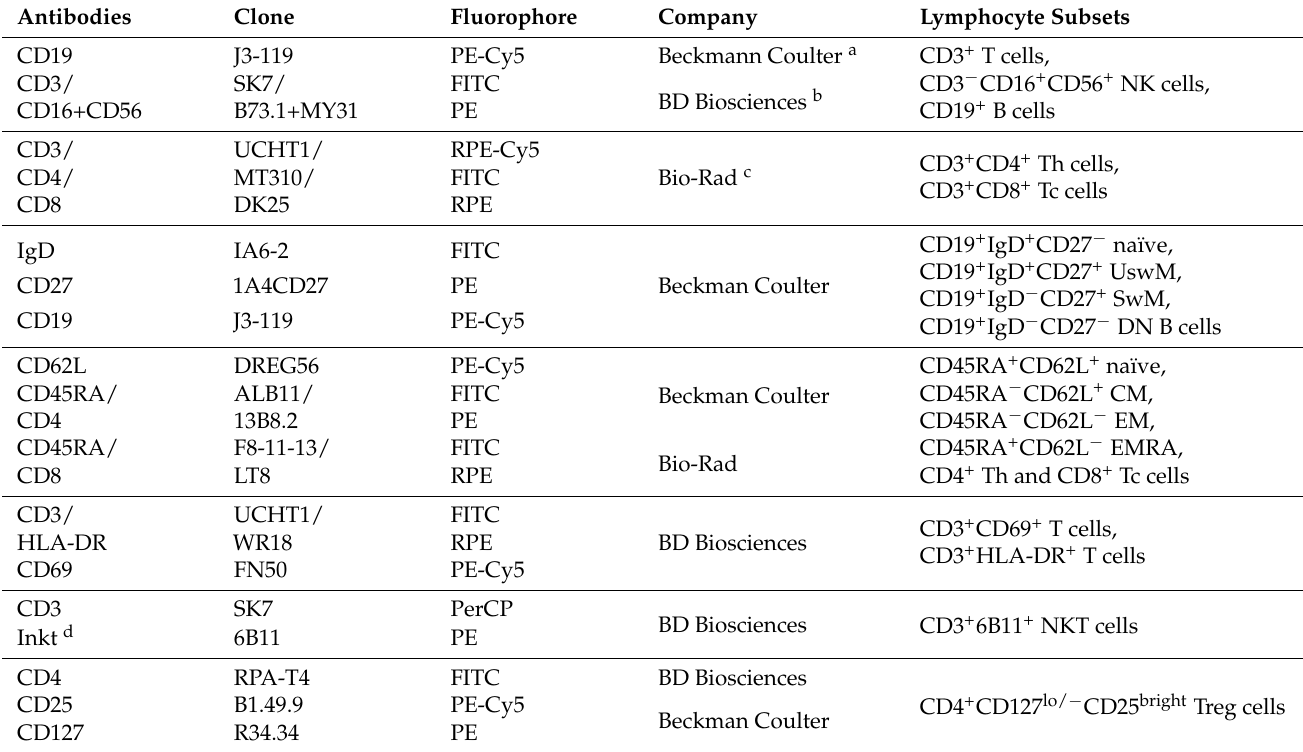
Table 1. List of fluorophore-conjugated monoclonal antibodies used in flow cytometry.